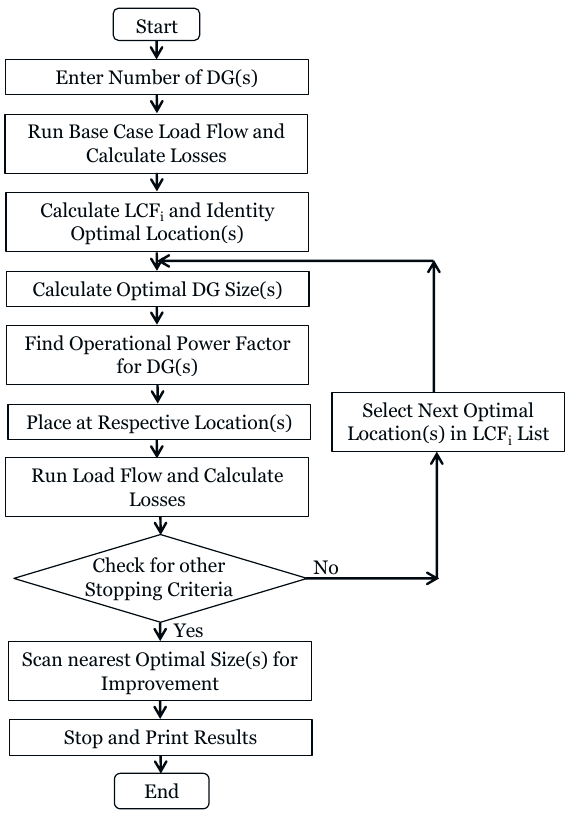
Figure 5. Flowchart of optimal